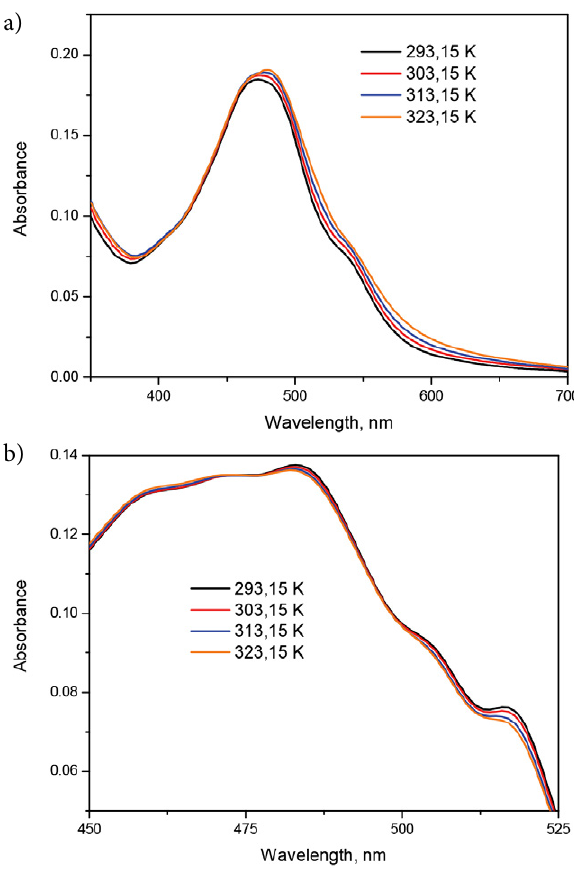
Figure 3. The influence of temperature on: (a) the absorption spec- trum of quinizarin and (b) the absorption spectrum of quinizarin incorporated in SDS micelles.